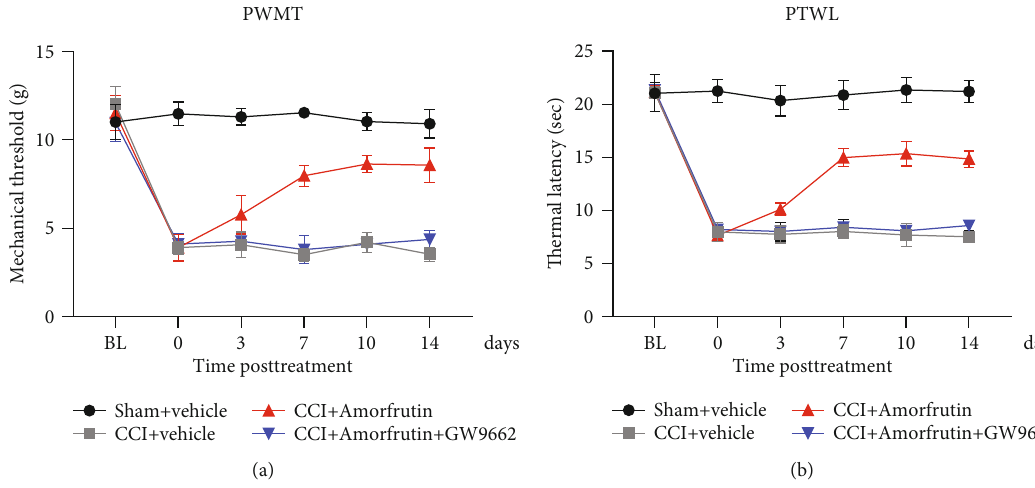
Figure 2: Amorfrutins relieved the neuropathic pain responses in CCI rats. (a) The PWMT of di ff erent groups were measured using the electric von Frey fi lament. (b) The PTWL of di ff erent groups were measured using the Plantar Analgesia Meter for thermal paw. Amorfrutins increased the PWMT and PTWL of CCI rats by activating PPAR γ